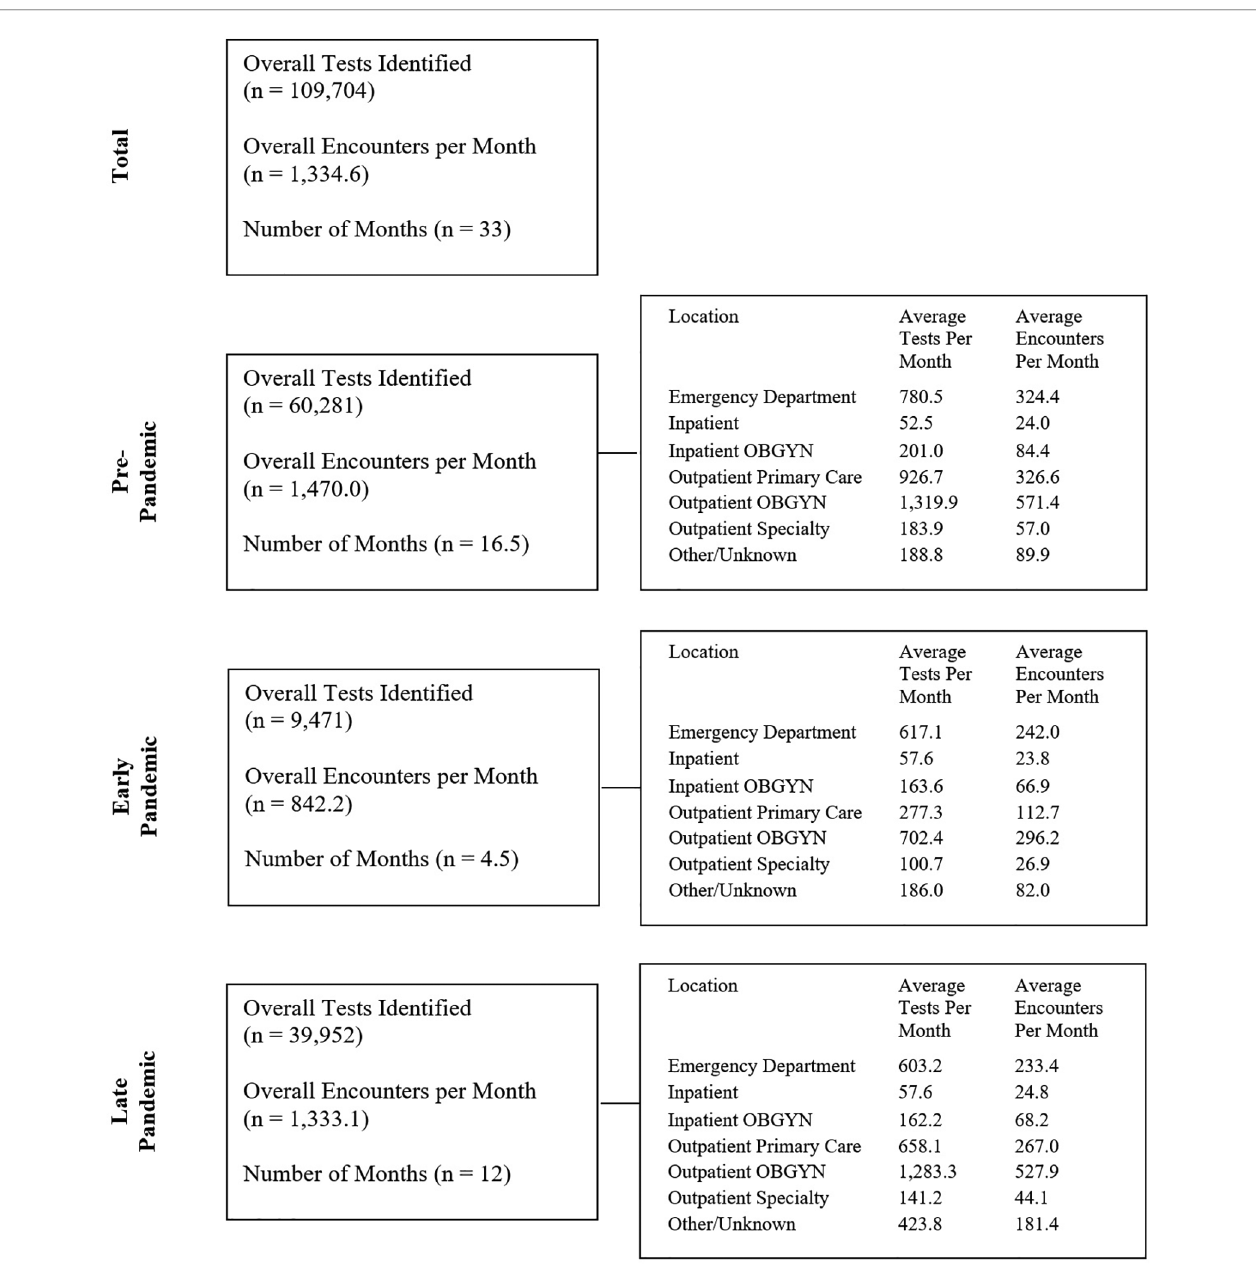
FIGURE 1 Number of STI tests and encounters for STI testing during the pre-pandemic, early pandemic and late pandemic periods, and rates of STI encounters and STI tests for each period by location of